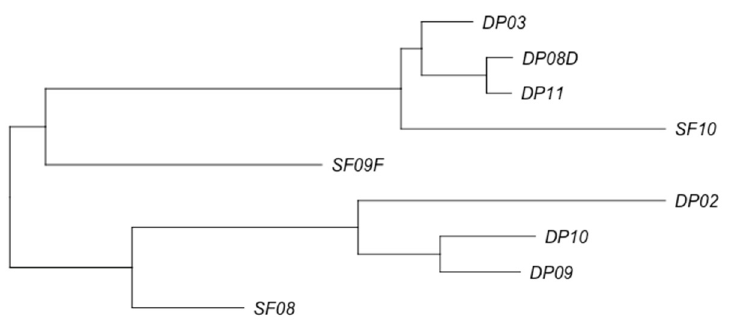
Figure 3. Phylogenetic tree obtained for sequences of amplicons generated with Lactococcus c2 phage- type primers with metagenomic DNA from curd cheeses from dairy plants (DP-) and spontaneous in-house fermentations